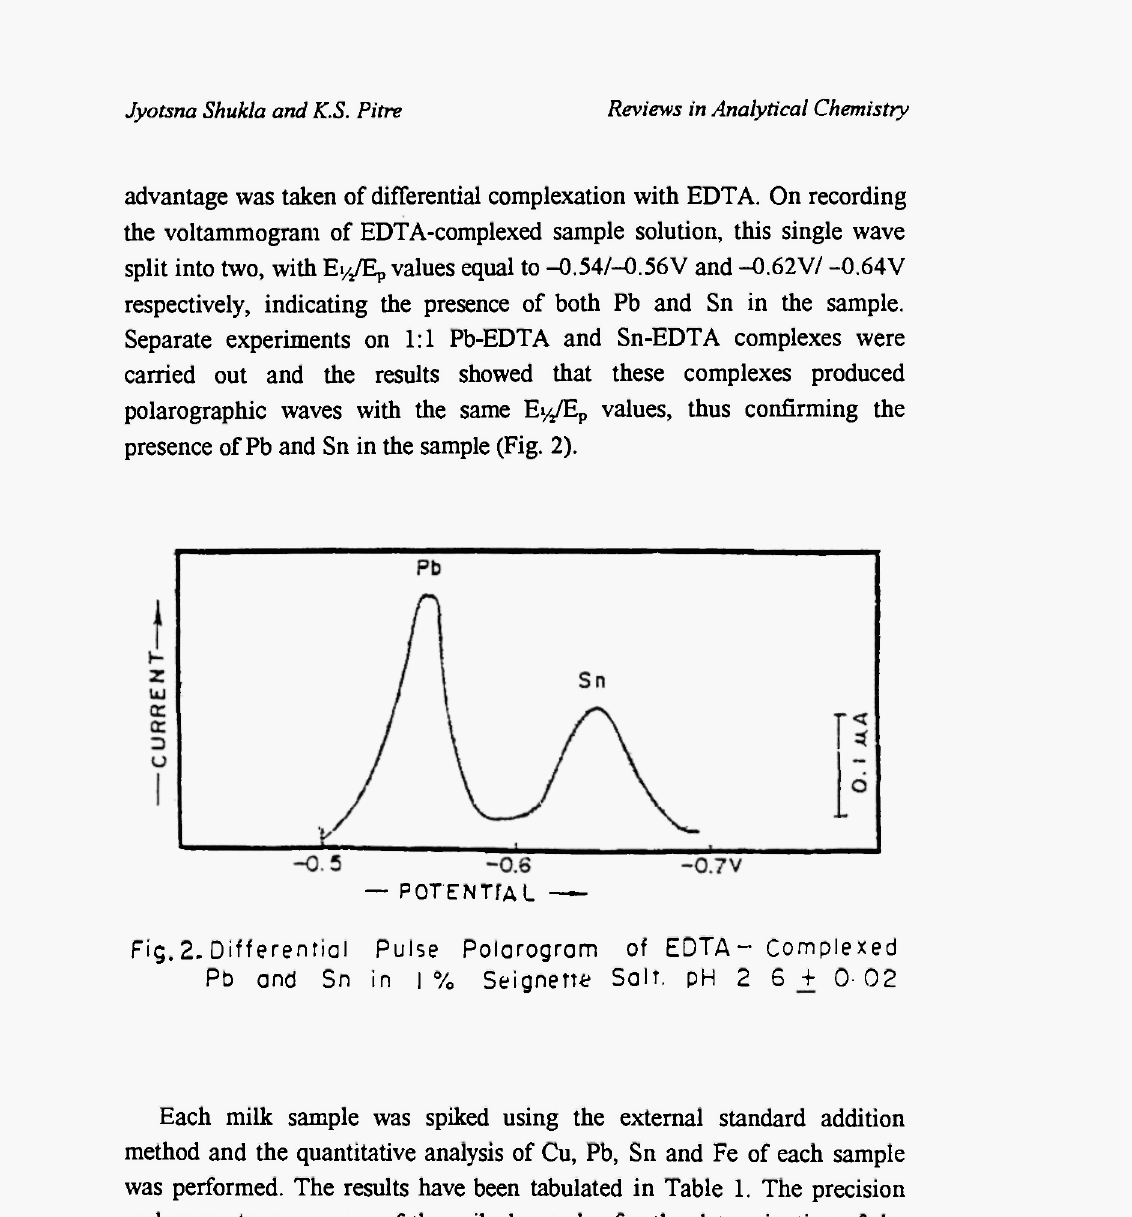
— POTENTIAL — Fig.2. Differential Pulse Polarogram of E D T A- Complexed Pb and Sn in | % Seignette Salt. pH 2 6 + 0 -